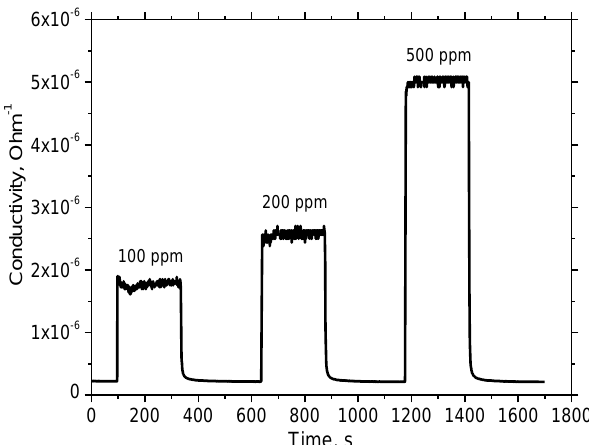
Figure 9. Sensor response to different concentrations of hydrogen at RH60.